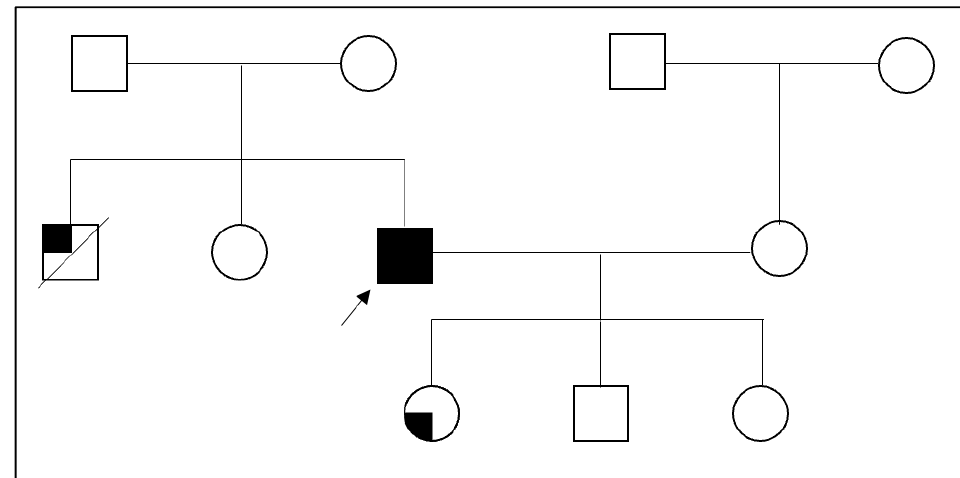
Figure 2. Family tree of the patient. Note: Arrow denotes the patient with Dent disease. Square represents male member, and circle represents female member. The quarter-filled square represents the patient’s brother with renal hypoplasia, whereas the quarter-filled circle represents the patient’s daughter with nephrocalcinosis.